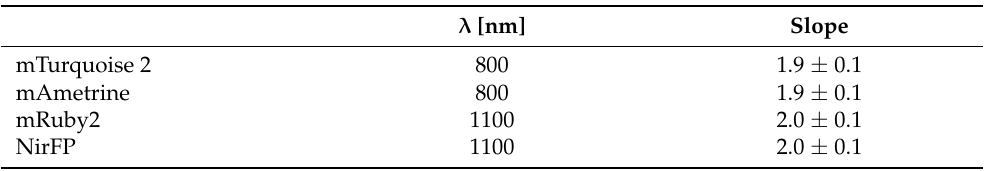
Figure 2. Logarithmic dependence of the background-corrected fluorescence (F-BG) generated by two-photon excitation on the time-averaged excitation power entering the objective lens. ( A ) mAmetrine (black dots) and mRuby2 (unfilled squares). ( B ) mTurquoise (crossed squares) and NirFP (black triangles). The fluorescent proteins were expressed in the cytosol of transfected HEK-293T cells. P_Obj is the excitation power measured under the objective lens. The dotted lines are the linear fits, and the slopes are given in parentheses. Table 1. Resulting slope per fluorescent protein expressed in the cytosol of transfected HEK-293T cells and excitation wavelength.